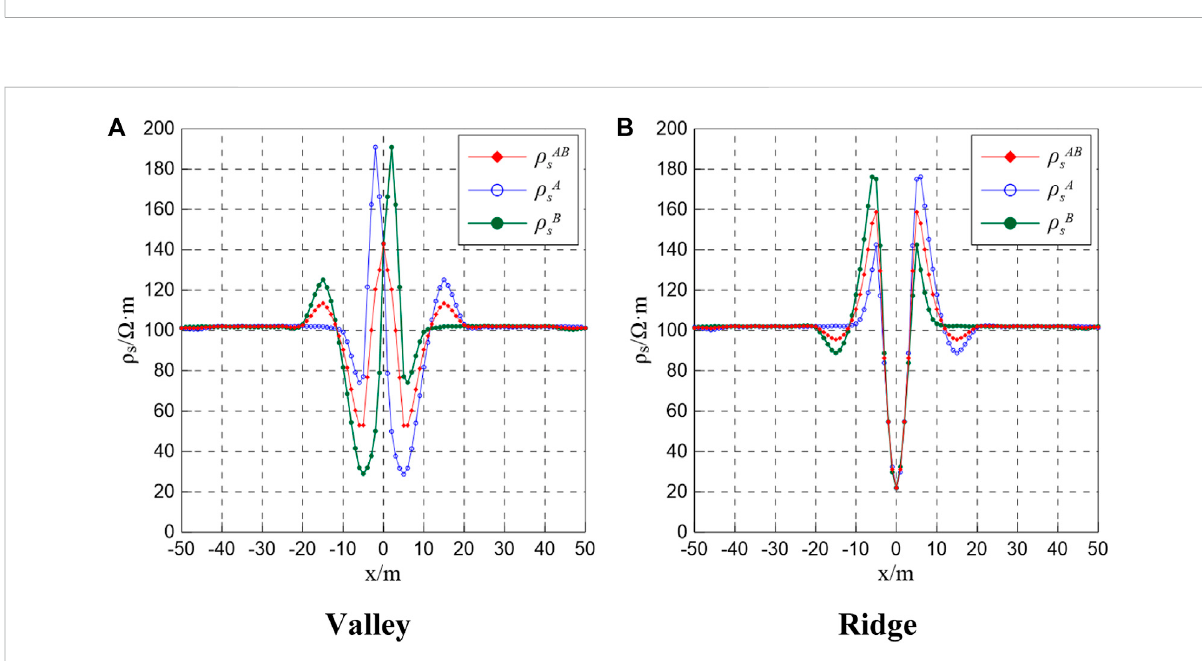
FIGURE 5 Point source joint pro fi le anomaly curves for (A) valley and (B)